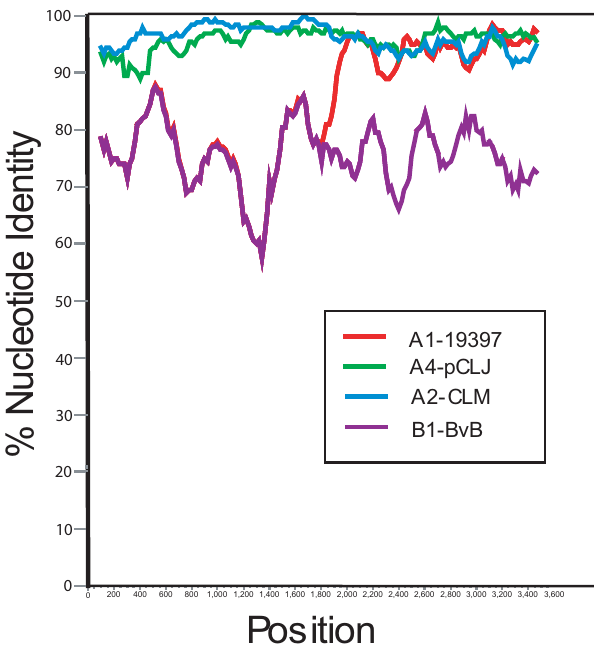
Figure 2. Simplot comparing the NTNH subtype sequences to the Loch Maree strain. The NTNH genes within BoNT/A1, BoNT/A2, BoNT/ A4, BoNT/B1 and BoNT/bvB subtypes were compared to the NTNH gene within the BoNT/A3, Loch Maree strain. The plot shows the similarity of the NTNH genes within each of these subtypes along the length of the gene and shows a recombination event in the middle of the A1 NTNH gene (at approximately 1800 bp) where the sequence becomes more similar to the A3 NTNH in the second half of the gene.